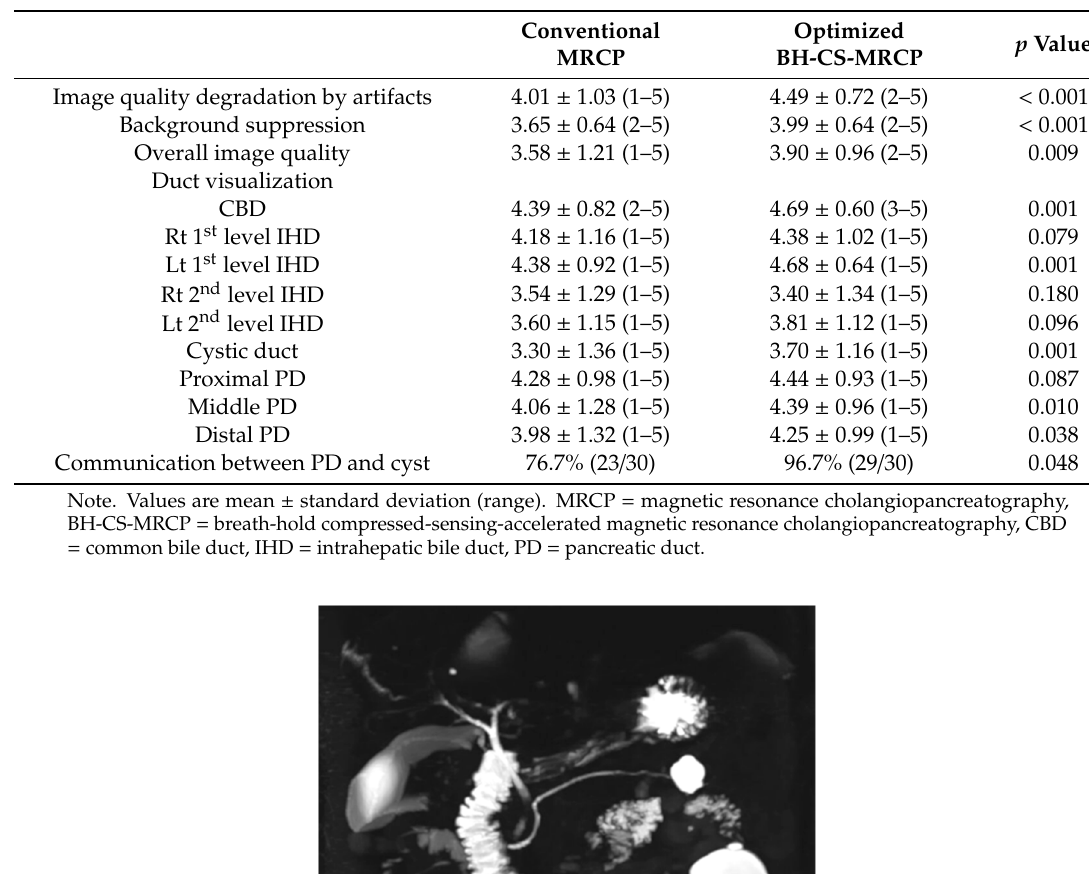
Table 2. Comparison of image quality between conventional MRCP and BH-CS-MRCP.